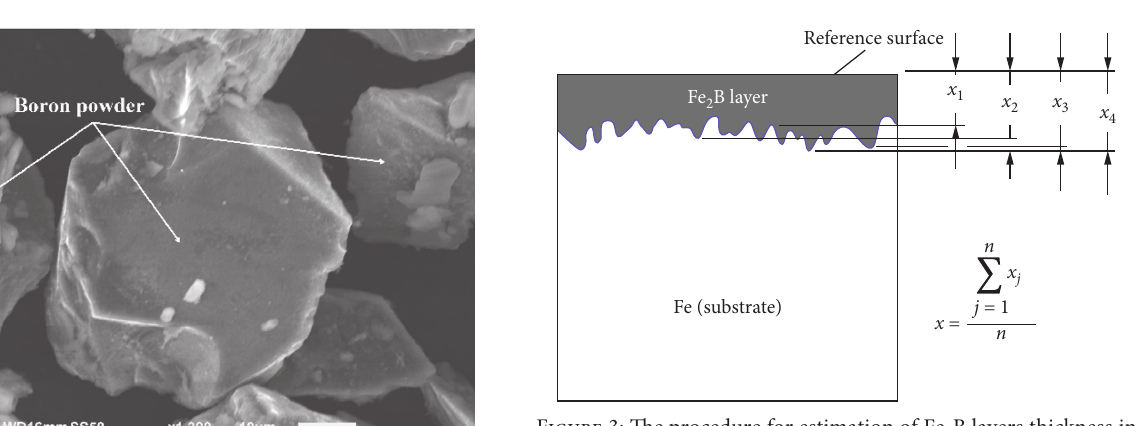
2 B layers thickness in